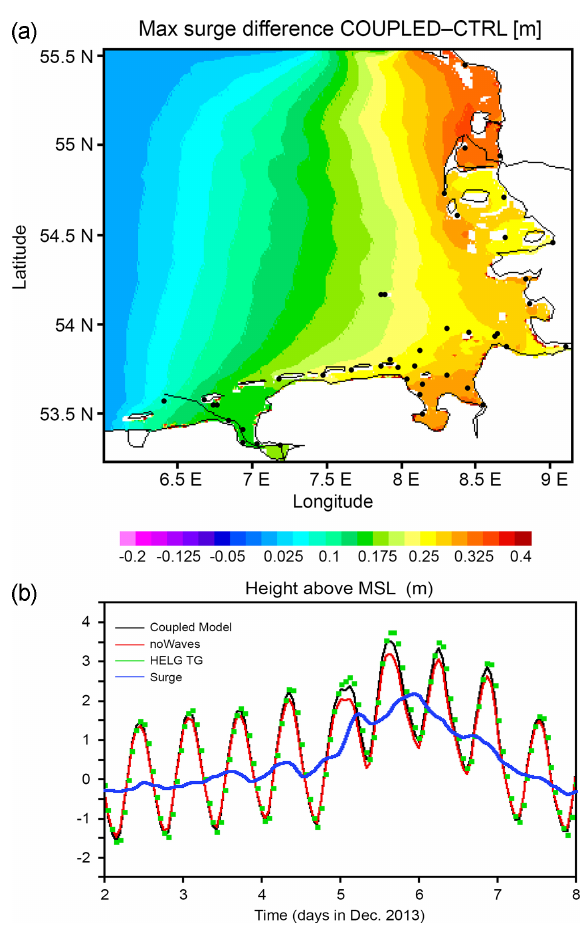
Figure 6. (a) Difference between sea-surface elevation (SLE) be- tween a coupled wave-circulation model (WAM-GETM) and the circulation-only model (GETM) for the German Bight during storm Xavier on 6 December 2013. (b) Time series of sea-level elevation (SLE) in meters at the Helgoland tide gauge station. Black line: cou- pled wave-circulation model; red line circulation only model; green: tide gauge observations; blue line: the